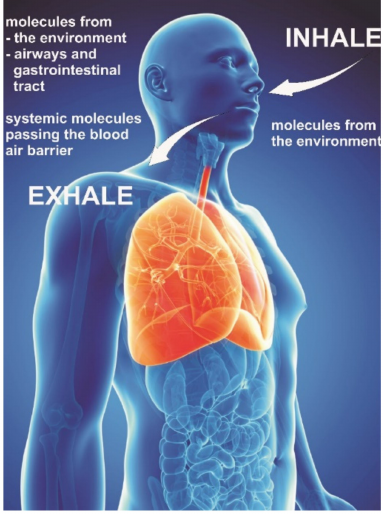
Figure 13. Exhaled molecules in the body originate partly from the airways, gastrointestinal tract, or the whole body (i.e., systemic molecules passing the blood-air barrier in the lungs) and from environmental molecules inhaled (modified from